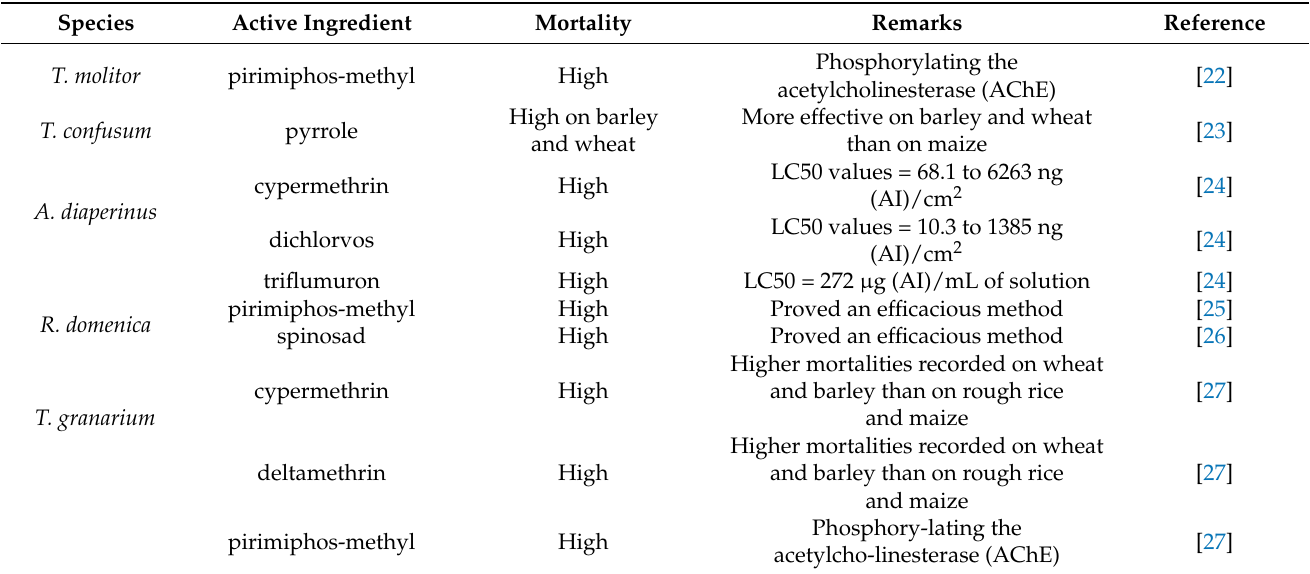
Table 3. Experimental data from previously published time–mortality bioassays of chemical insecti- cides against adults of the species tested in this